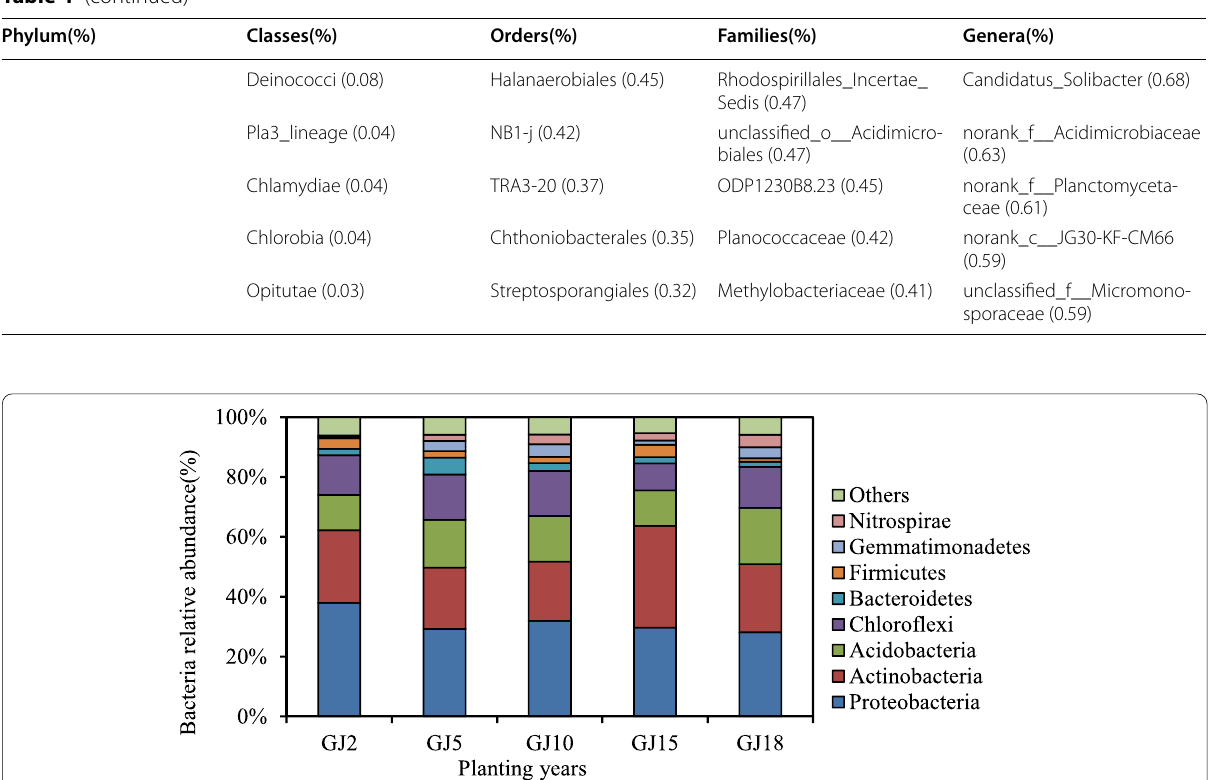
Fig. 3 Soil bacterial phylum levels distribution of citrus tree orchards with different ages